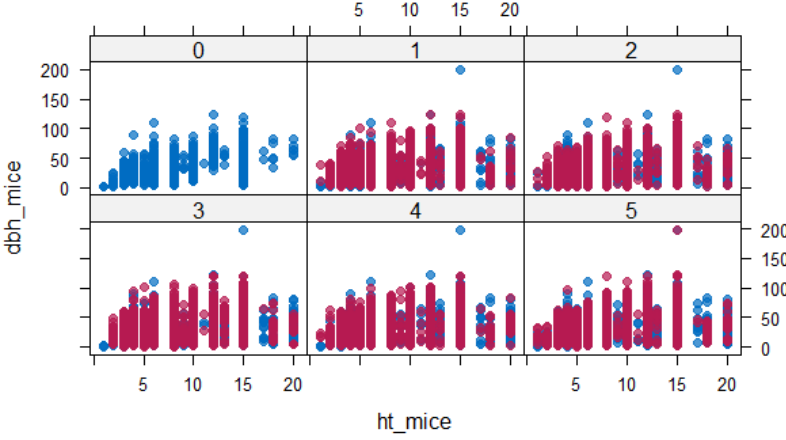
Figure 3. Scatter plot for dbh (dbh_mice) and ht (ht_mice), where the blue points correspond to observed values and red points to imputed values. Each panel correspond to one of the five imputations. The blue points were the same across all the panels (each panel representing one of the five imputations), but the red points varied. The red points had more or less the same shape as the blue points, indicating that they could have been plausible measurements if they had not been